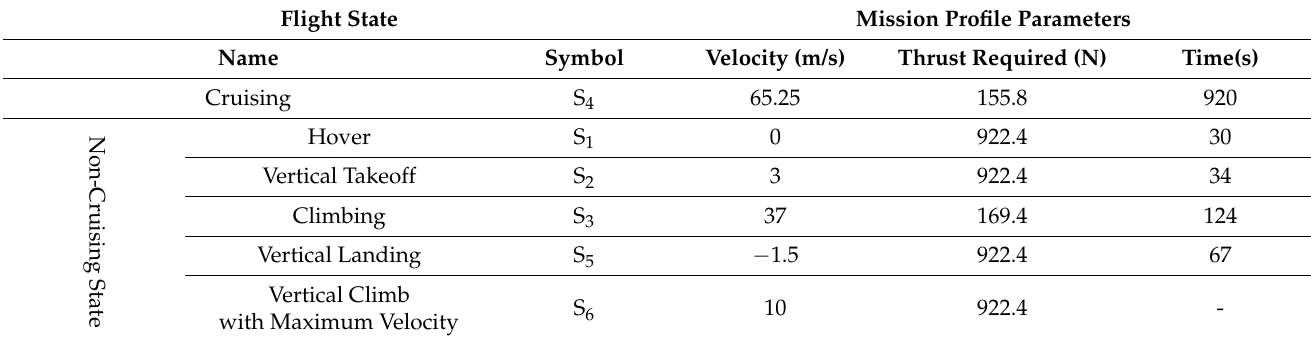
Table 1. Mission profile parameters.